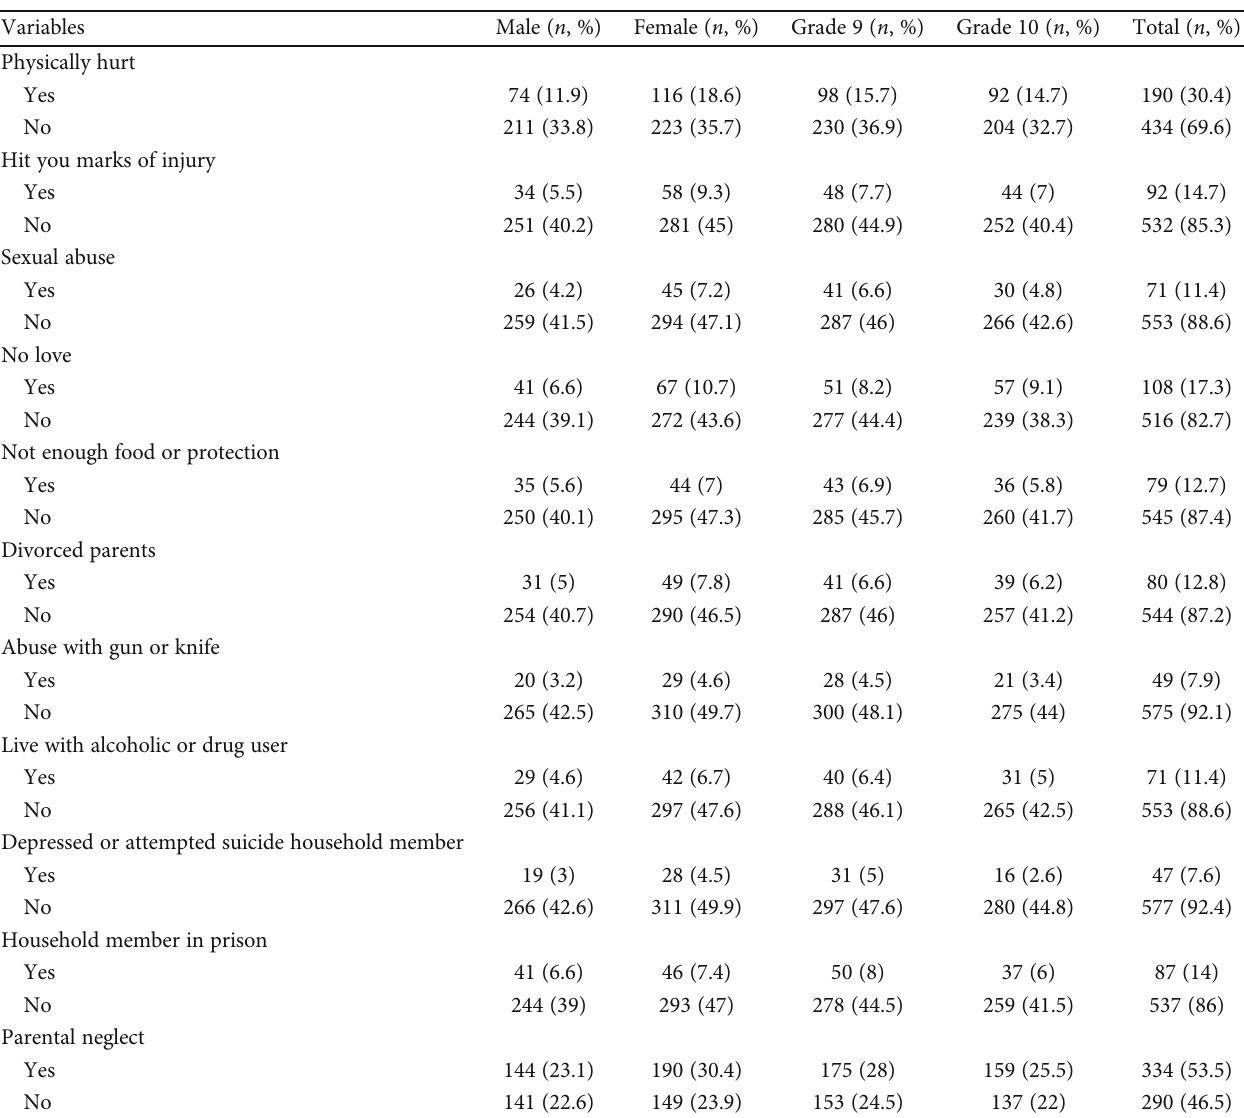
Table 2: Distribution of Adverse Childhood Experience Questionnaire by sex and educational level among adolescents in the sampled governmental high schools in Aksum town, Ethiopia, 2019 ( n = 624